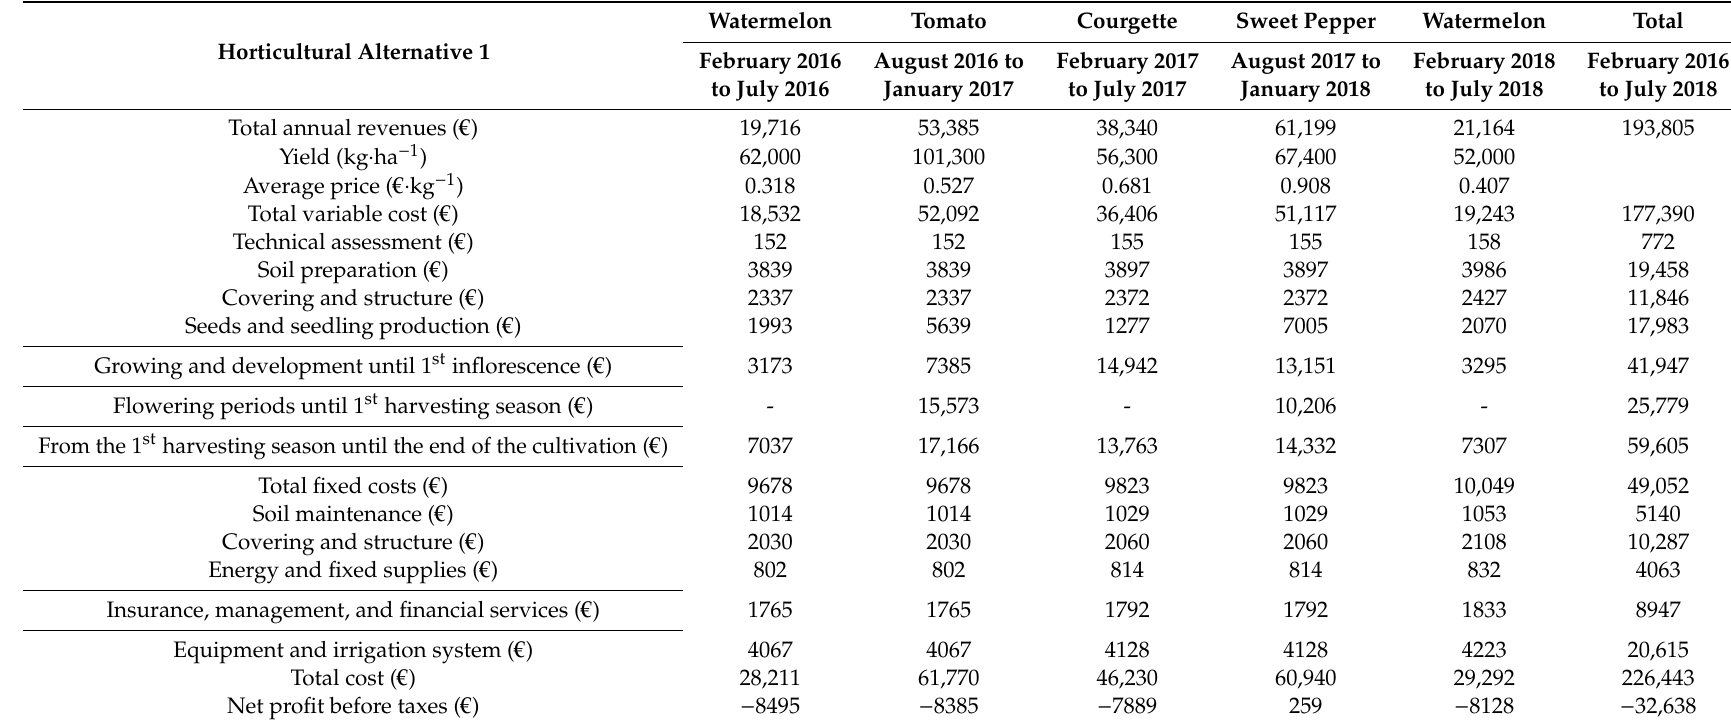
Table A3. Revenues and expenses per hectare imputed to the cultivation of the horticultural alternative 1 in a 30-month cycle